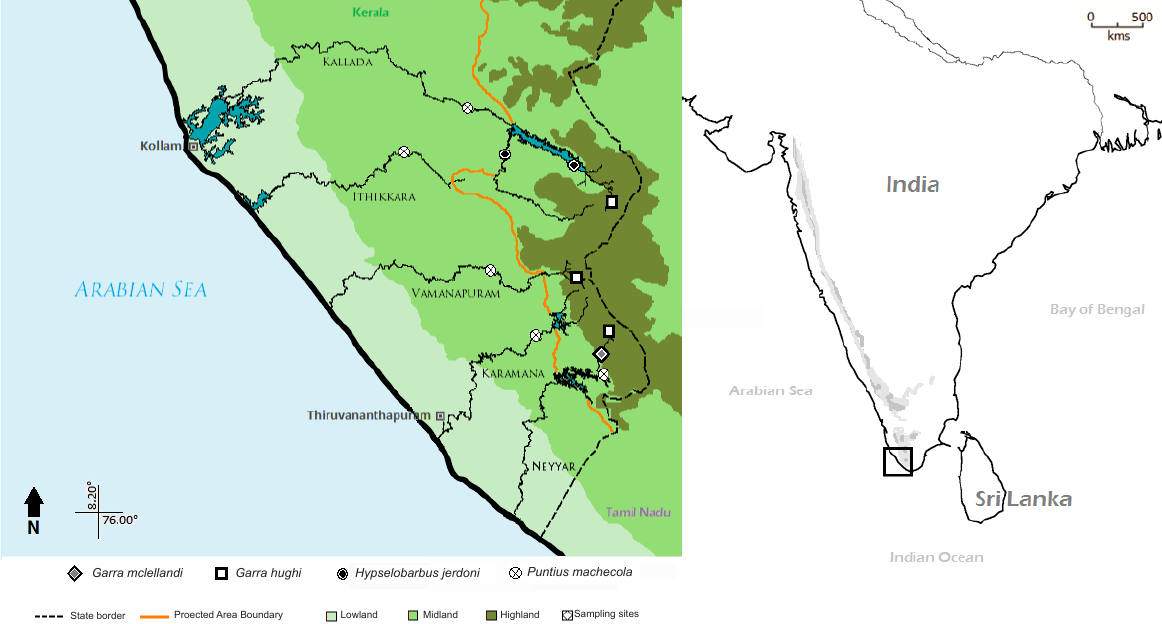
Figure 1. Map showing study area with locations indicated, where species’ range extension were recorded in the Ashambu Hills (© Robin